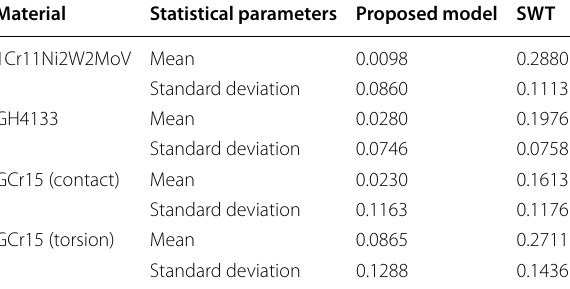
Table 6 Statistical analysis of model prediction errors Material